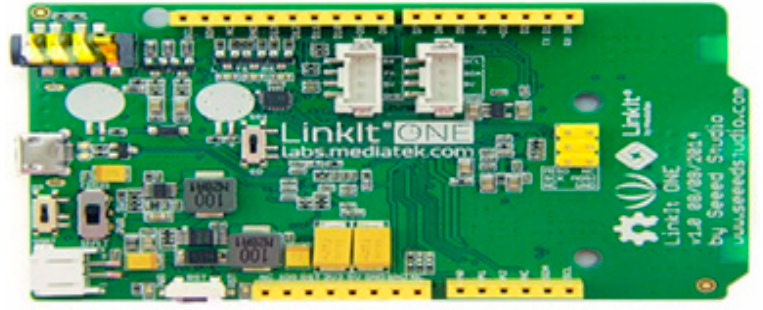
Figure 9. Linkit ONE hardware.